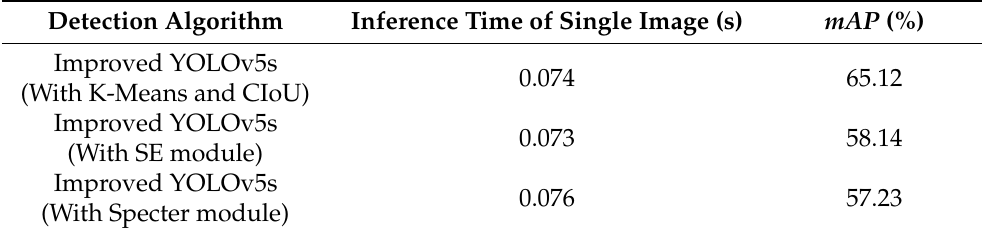
Table 5. Comparison of our improved YOLOv5s and other YOLOv5s